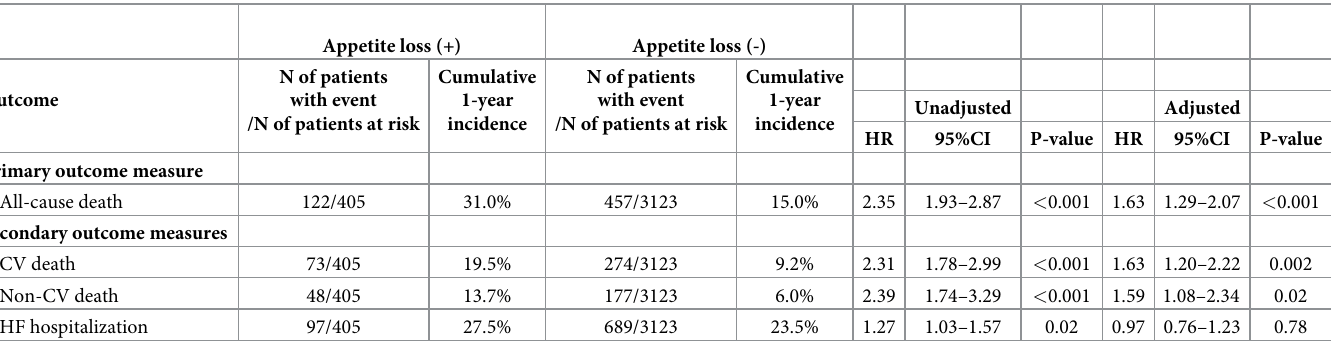
Table 3. Clinical outcomes at